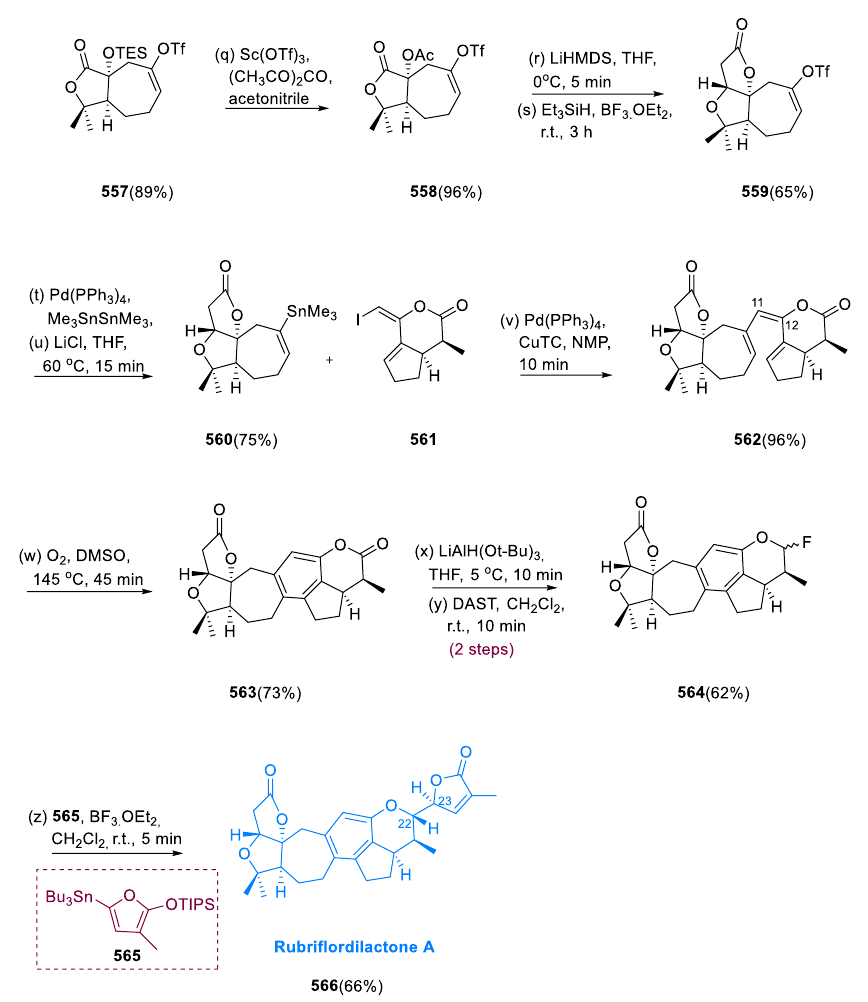
Scheme 33. Total synthesis of rubriflordilactone